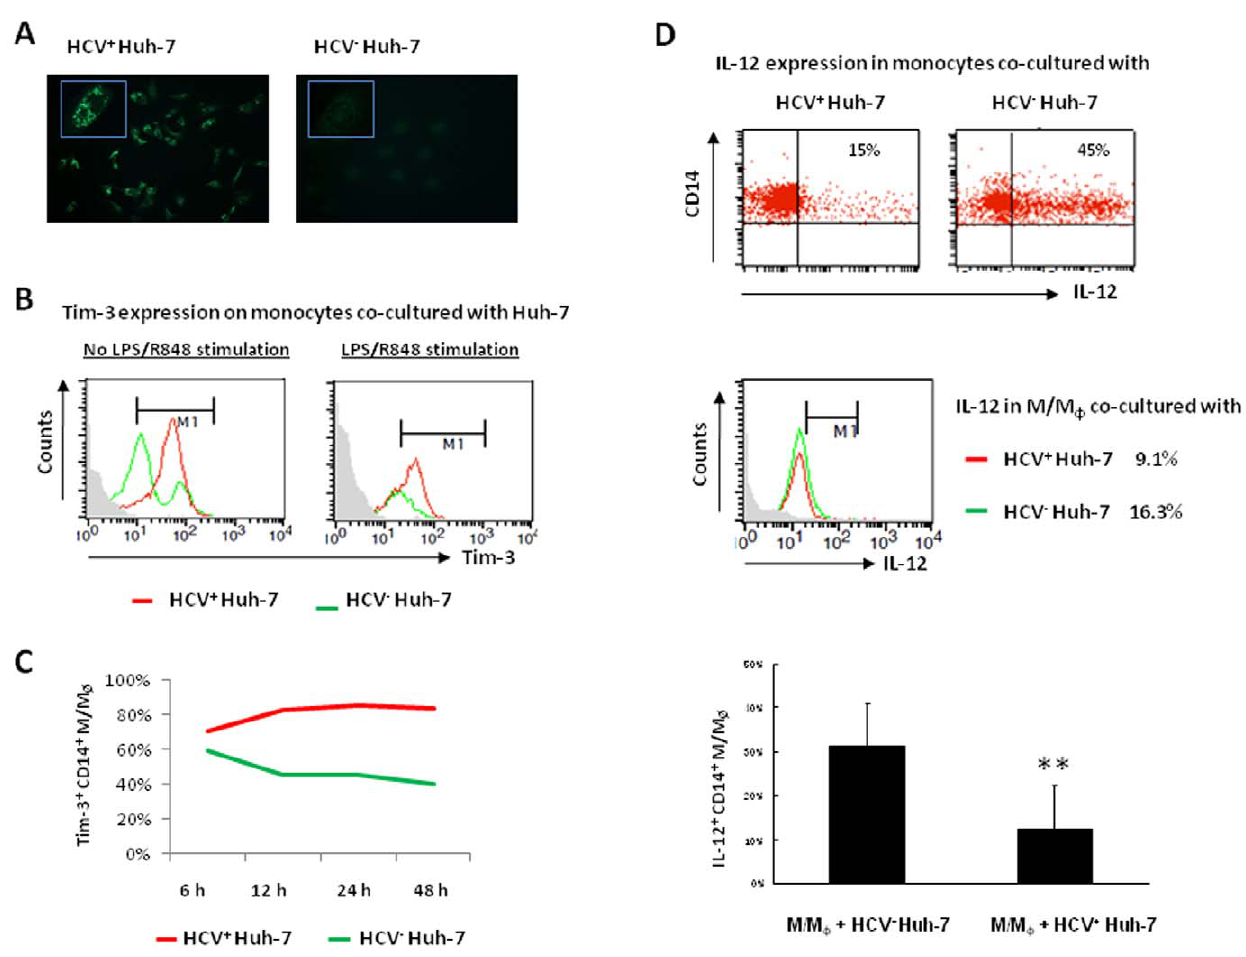
Figure 3. Tim-3 and IL-12 expression in M/M Ø is differentially regulated by hepatocytes expressing HCV. A) Immunofluoresence staining of HCV core protein in Huh-7 cells 48 h after HCV-JFH-1 (left) or mock (right) transfection. Higher magnificent imaging ( 6 40) is inserted at upper left corner. B) Tim-3 expression on M/M Ø co-cultured with HCV-transfected (red line) or mock-transfected (green line) Huh-7 cells without (left) or with (right) LPS/R848 stimulation. C) Representative Time-course of Tim-3 expression on CD14 + M/M Ø co-cultured with HCV + Huh-7 versus HCV 2 Huh-7 cells from two reproducible experiments. D) IL-12 expression in M/M Ø co-cultured with HCV + Huh-7 versus HCV 2 Huh-7 cells, shown as dot plot, histogram, and bar figure in multiple experiments.